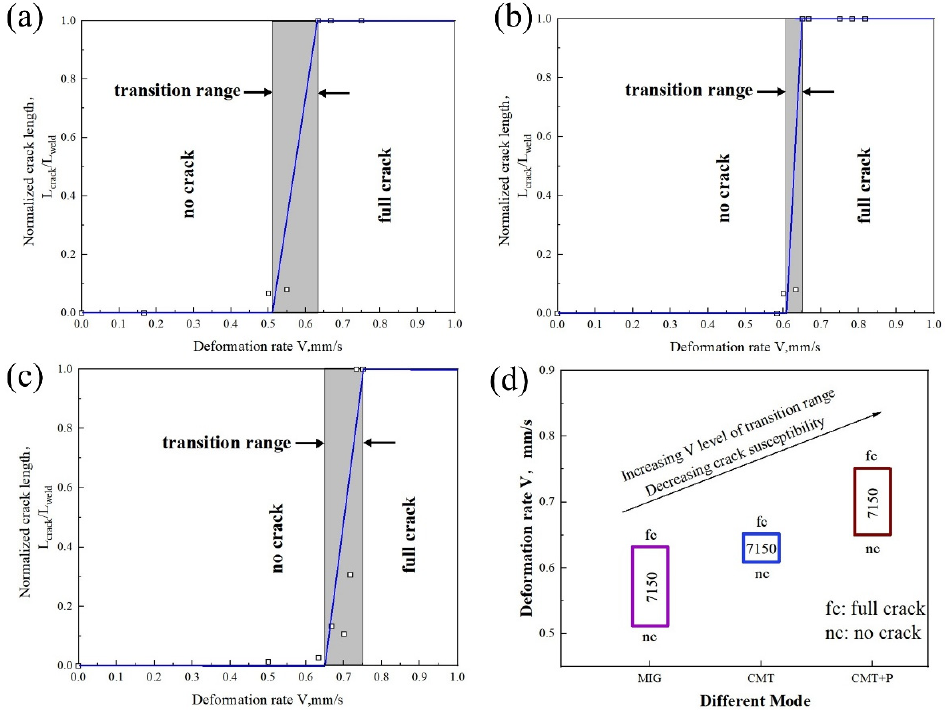
Figure 12. Test results of 7075 Al welded with 7150 Al as filler metal: ( a ) MIG mode; ( b ) CMT mode; ( c ) CMT+P mode; ( d ) comparison among different arc modes.